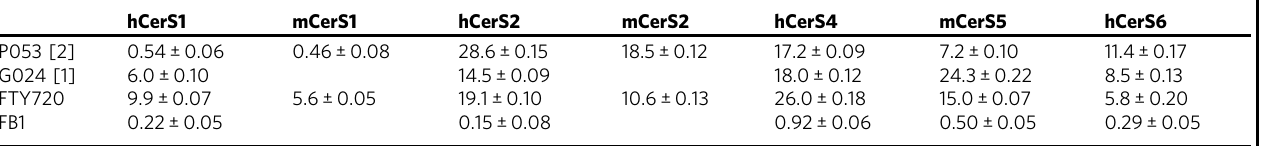
Table 1 IC 50 for inhibition of ceramide synthases by P053